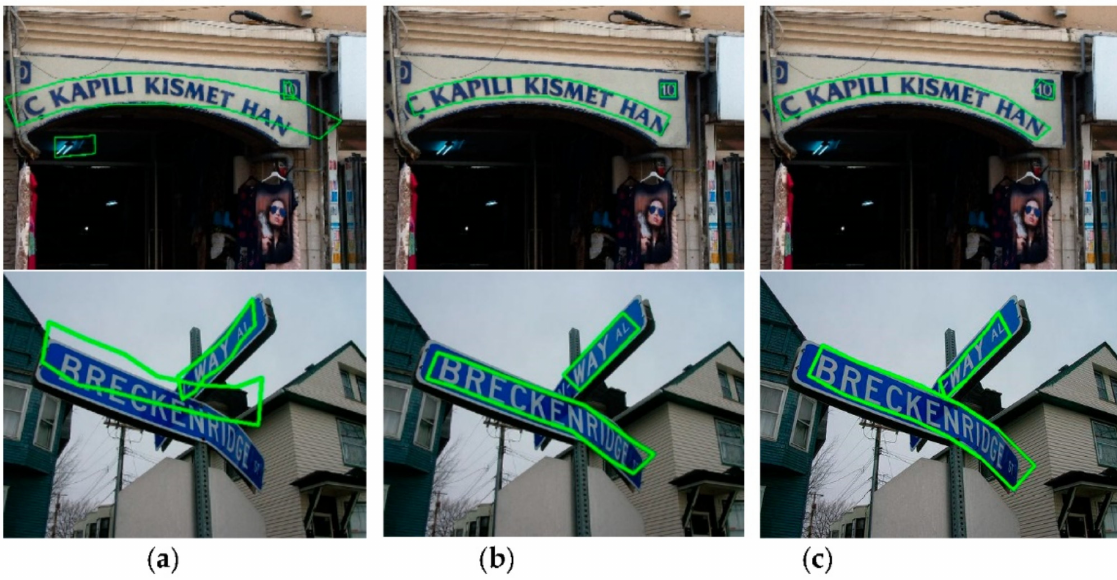
Figure 6. Comparison results of several methods, ( a ) CTD + TOLC [8], ( b ) CRAFT [34], and ( c )